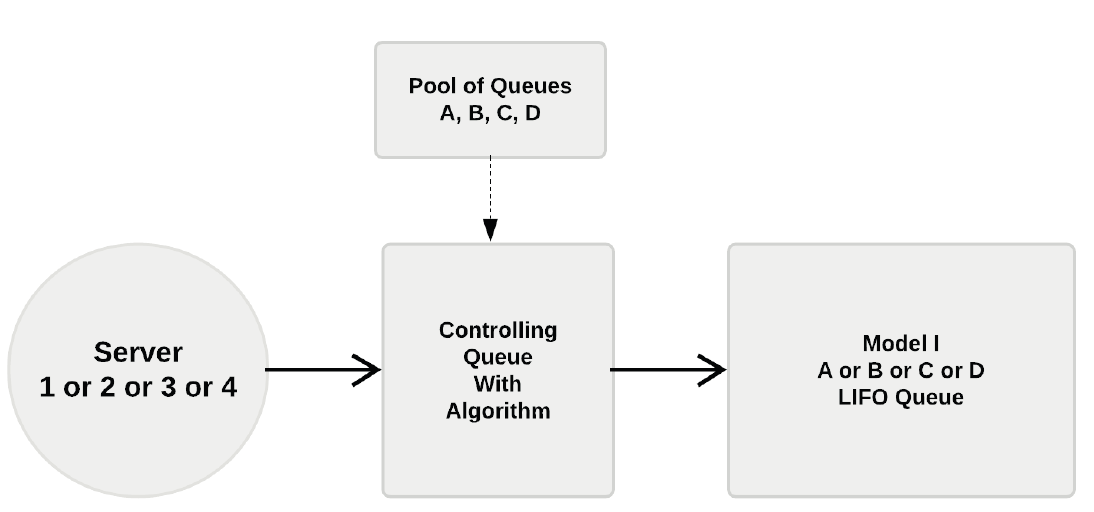
Figure 8. Block scheme of controlling entity path to the right queue in the storage